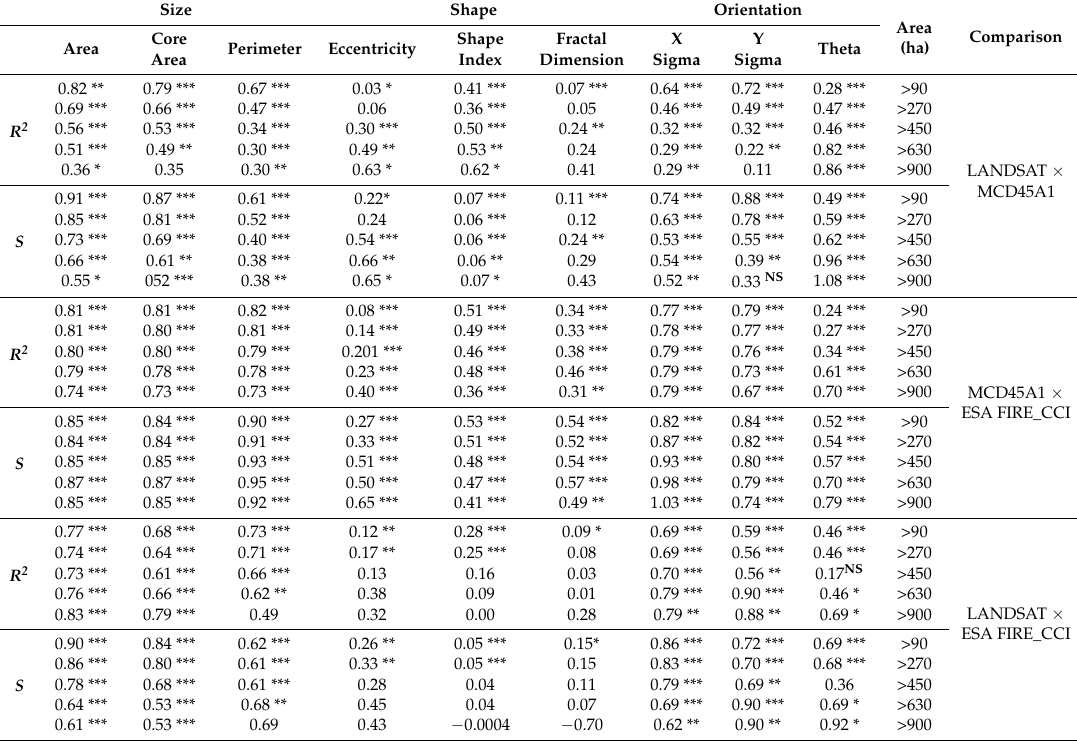
Table A1. Slope ( S ) and determination ( R 2 ) coefficients of linear regression for patch metrics in each comparison among fire